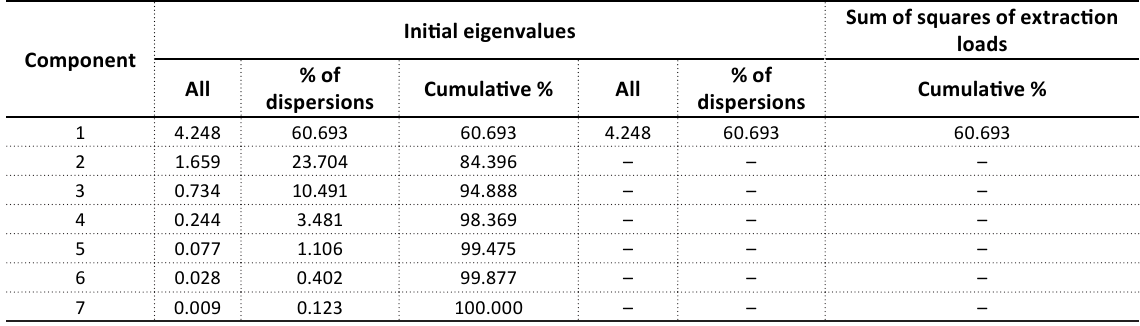
Table 4. Total dispersion that is explained by the first main component (Total Variance Explained)